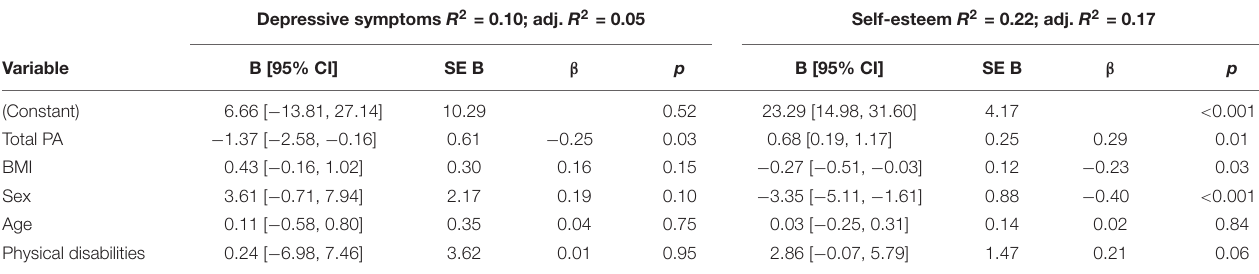
TABLE 2 | Regression analyses of total PA on depressive symptoms and self-esteem. Depressive symptoms R 2 = 0.10; adj. R 2 = 0.05